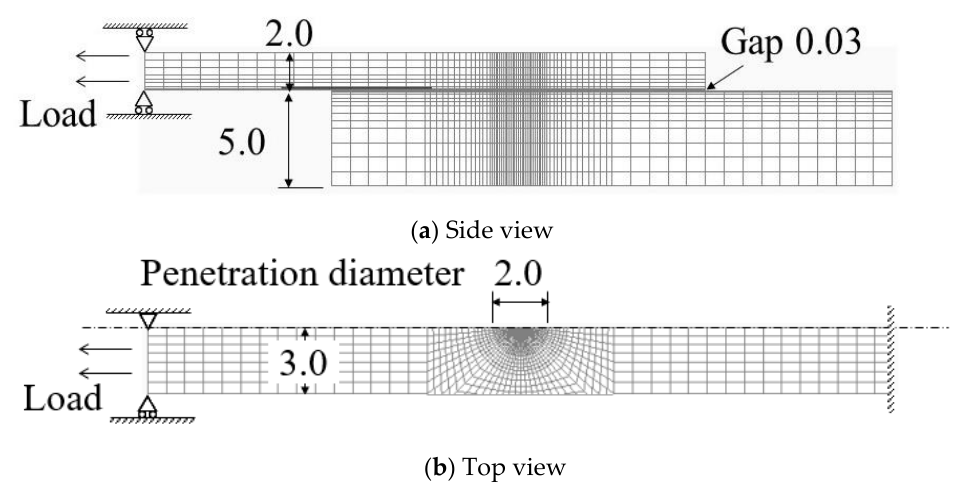
Figure 6. Size and FEM analysis model of the specimen. ( a ) Side view; ( b ) Top view.